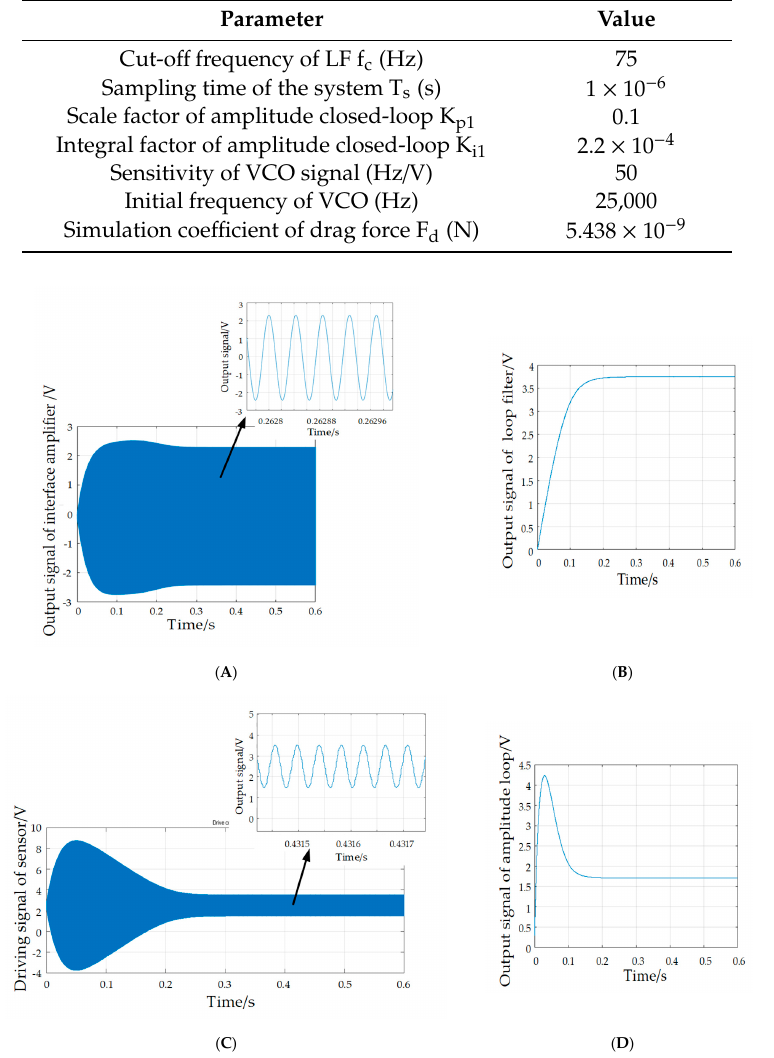
Figure 7. Waveforms of key signals. ( A ) Output of interface amplifier. ( B ) Output signal of loop filter. ( C ) Driving signal of sensor. ( D ) Output signal of amplitude loop.